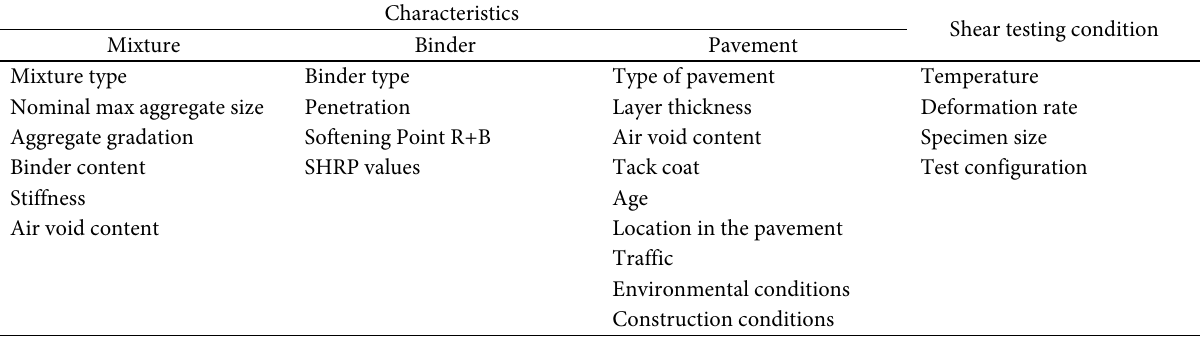
Table 1. List of general variables influencing the interlayer bond of asphalt pavements